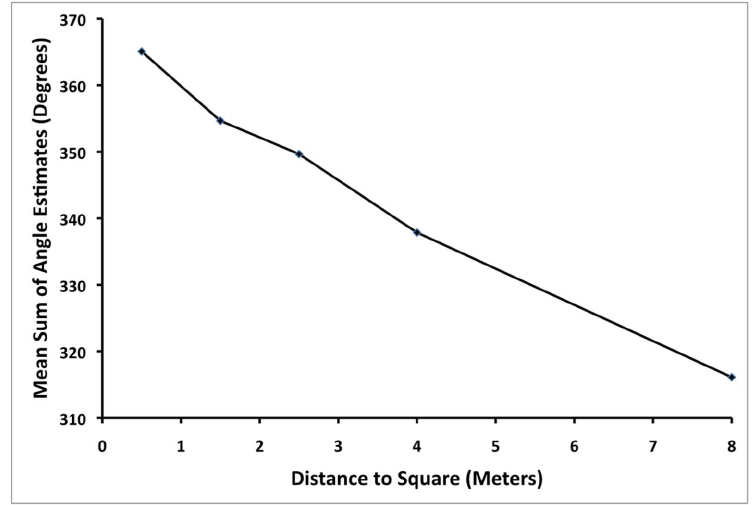
Figure 5. Mean sum of the angle estimates (in degrees) for each square as a function of distance (in meters) to the square from the observer to the square in Experiment